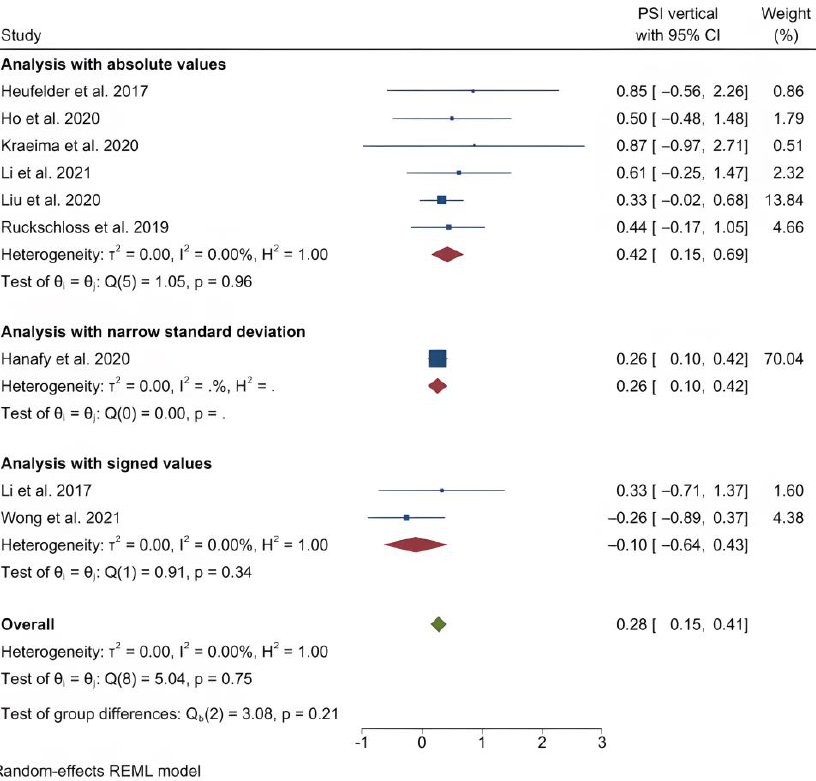
Figure 5. Forest plot showing mean vertical